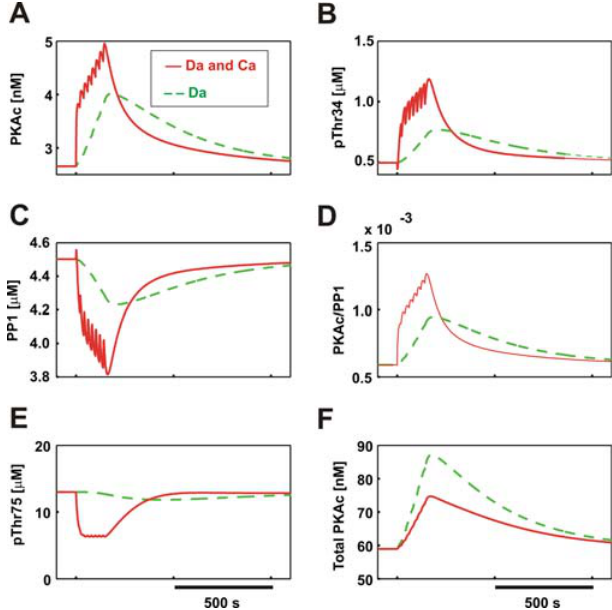
Figure 5. Effect of Simultaneous, Transient Calcium and Dopamine Inputs In all panels, the response to dopamine alone is shown with green dashed lines; the response to paired dopamine and calcium is shown with red solid lines. (A) The cumulative increase in free PKAc following eight high-amplitude, brief dopamine pulses with 20-s intervals, is enhanced when a high- amplitude, brief calcium input is paired with each dopamine pulse. (B) Phosphorylation of Thr34 is enhanced when calcium and dopamine inputs are paired. (C) PP1 inhibition is more pronounced when calcium and dopamine inputs are paired due to the increase in phosphoThr34. (D) The ratio of PKAc to PP1 is enhanced when calcium and dopamine inputs are paired. (E) Some dephosphorylation on Thr75 occurs following a dopamine input due to the PKA dependent activation of PP2A. When in addition calcium is transiently elevated, calcium-dependent activation of PP2A significantly decreases phosphoThr75. (F) The total formation of activated PKA (both free and bound to phosphoThr75) is larger with dopamine inputs alone. This is partly due to the calcium-dependent decrease in the cAMP formation, but also the PKAc interaction with phosphoThr75 is important. DOI: